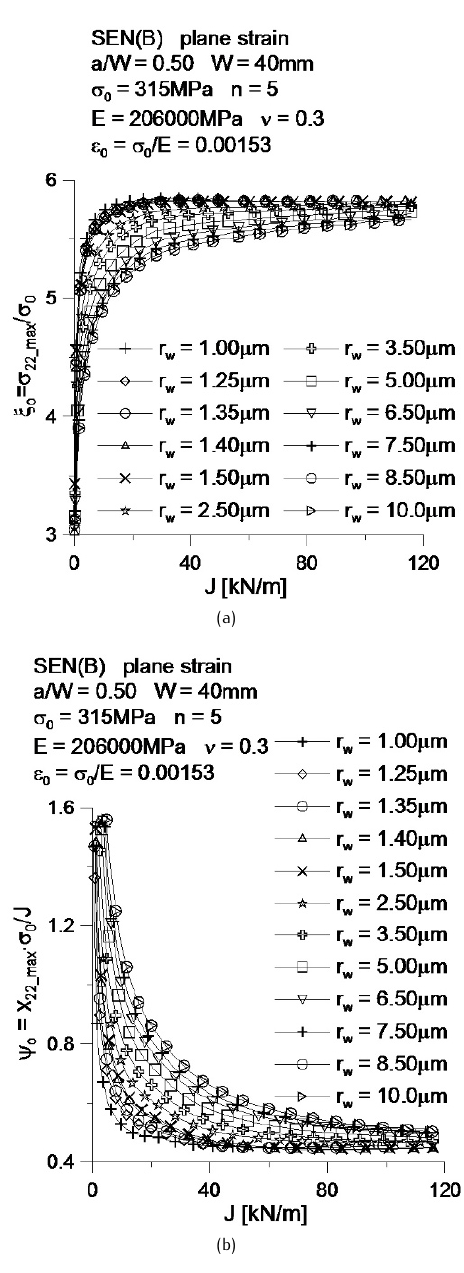
Figure 4. The influence of the size of crack tip radius on: (a) level of the maximum opening stress; (b) normalized location of the maximum opening stress (based on [11, 14, 16])